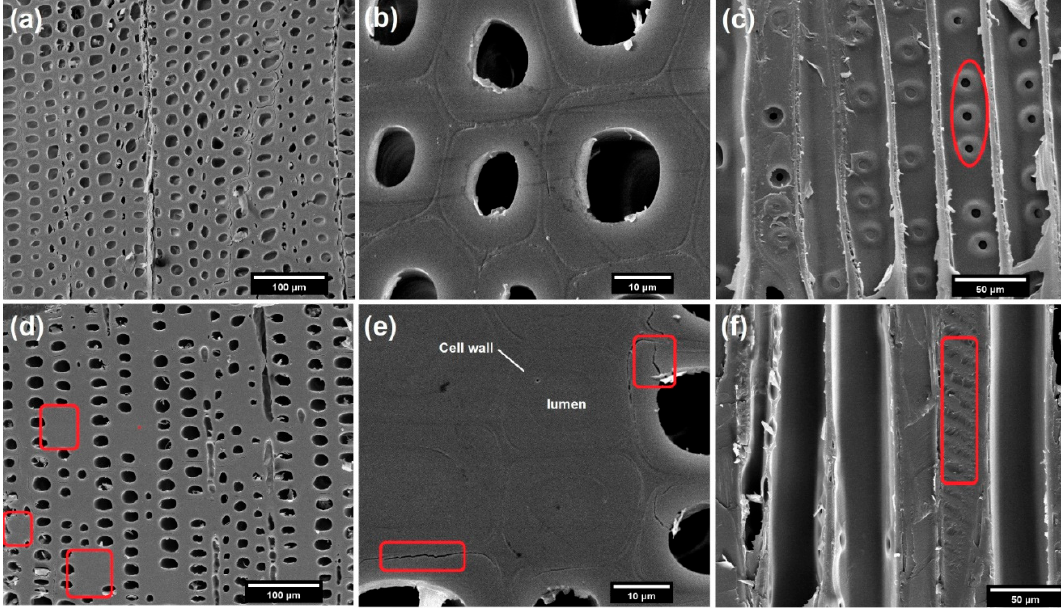
Figure 3. Micrographs of the cross-sections of ( a , b ) the control wood, ( d , e ) the wood modified by PF resin, and tangential-section of ( c ) the control wood, ( f ) the modified wood.